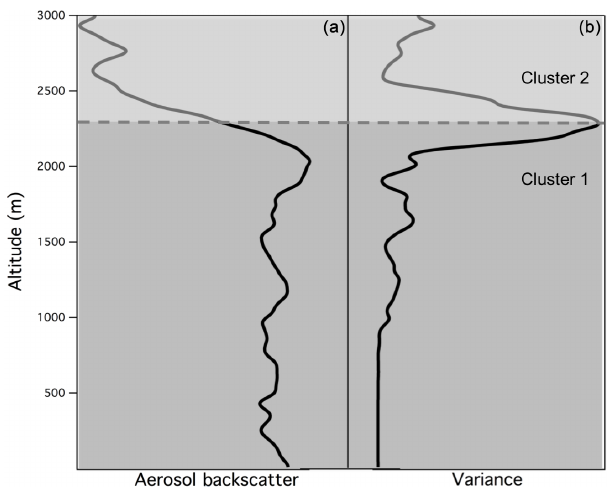
Figure 4. CL31 aerosol backscatter profile (a) and corresponding calculated variance profile (b) for 25 September 2014 at 14:30CST. Dashed line shows the cluster-derived BLH (2360m) at the height where the variance cluster assignment changes from cluster 1 to cluster